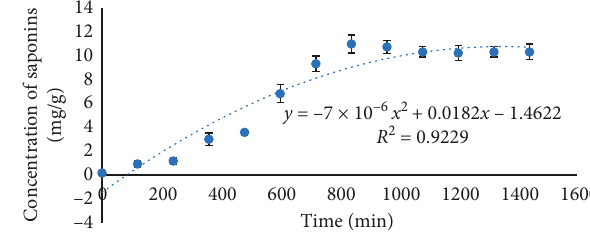
Figure 2: Kinetic equilibrium profile of saponin concentration (mg/g) with respect to extraction time (min).